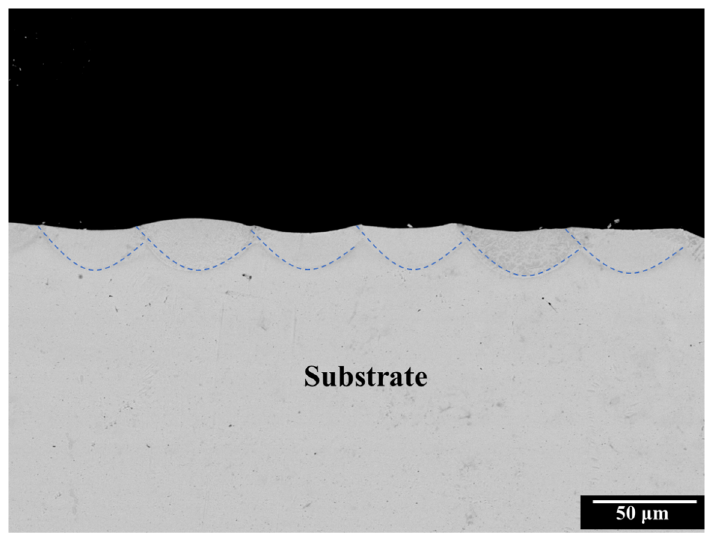
Figure 8. SEM image of the cross-section of polished single MoSiBTiC-La 2 O 3 layer with 50 μ m HD.